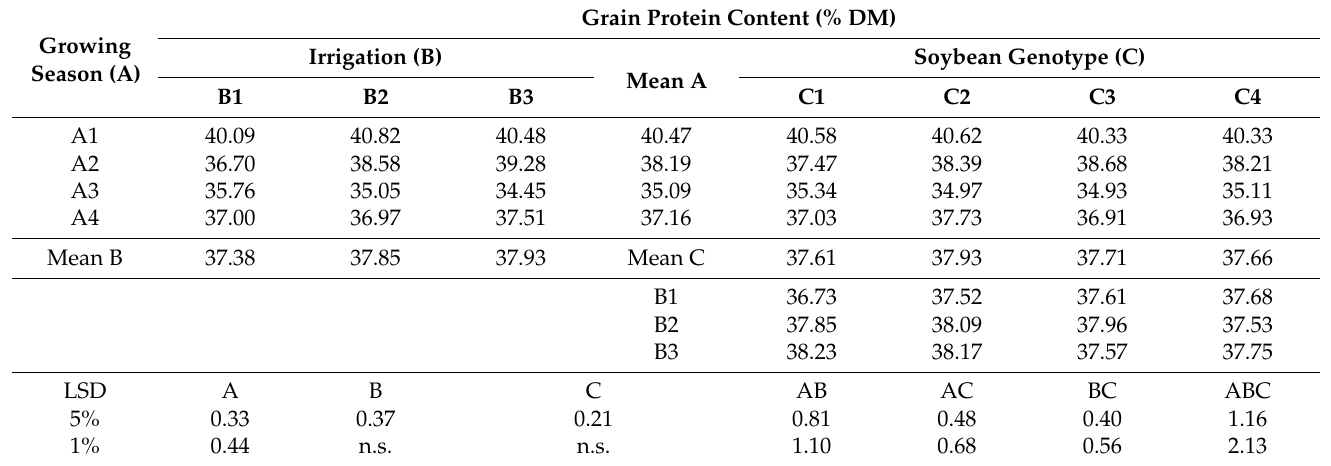
Table 3. Impacts of the environmental conditions in the four growing seasons (A1–A4), three treatments (B1, rain-fed conditions; B2, 60% of the field water capacity, or FWC; B3, 80–100% of the FWC), four genotypes (C1–C4) and their interactions (AB, AC, BC and ABC) on soybean grain protein contents (% dry matter, or DM). n.s. = not significant.